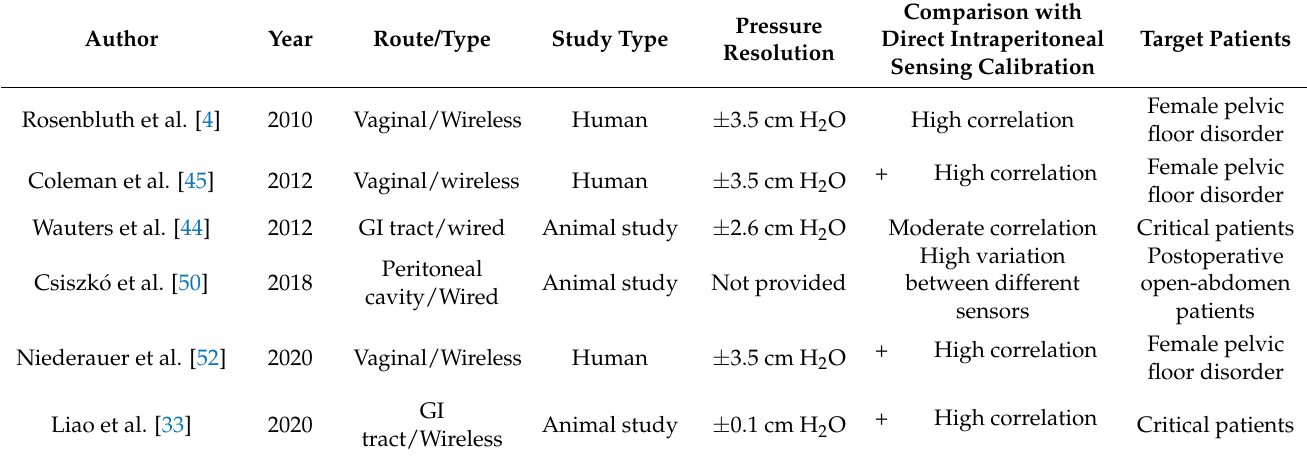
Table 4. Studies with intra-abdominal pressure-sensing systems with routes other than intravesical pressure measurement with detailed pressure